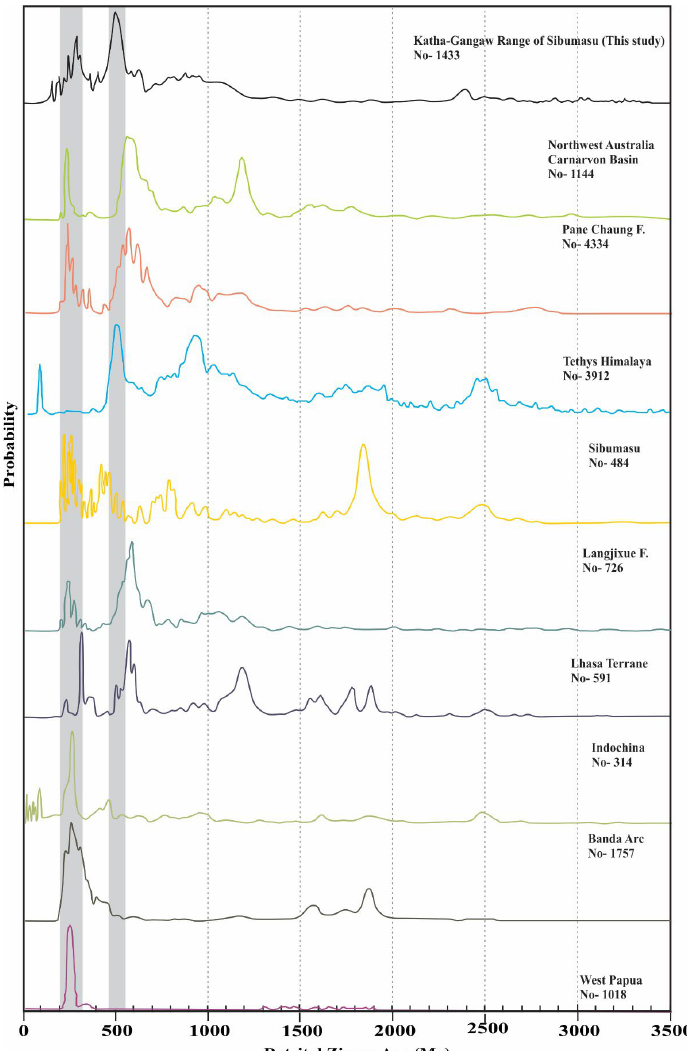
Figure 8. U-Pb age spectra for metamorphic rocks of the Katha-Gangaw range and rocks from the Tethys Himalaya [73,75], Lhasa terrane [76,77], Carnarvon basin of northwestern Australia [78], the Banda arc and West Papau [79], the Langjiexue Formation of southeastern Tibet [80], the Pane Chaung Formation of Myanmar [2,57], Indochina block [70], and Sibumasu block [23]. The grey bar highlights the peak ages corresponding to the adjoining regions.